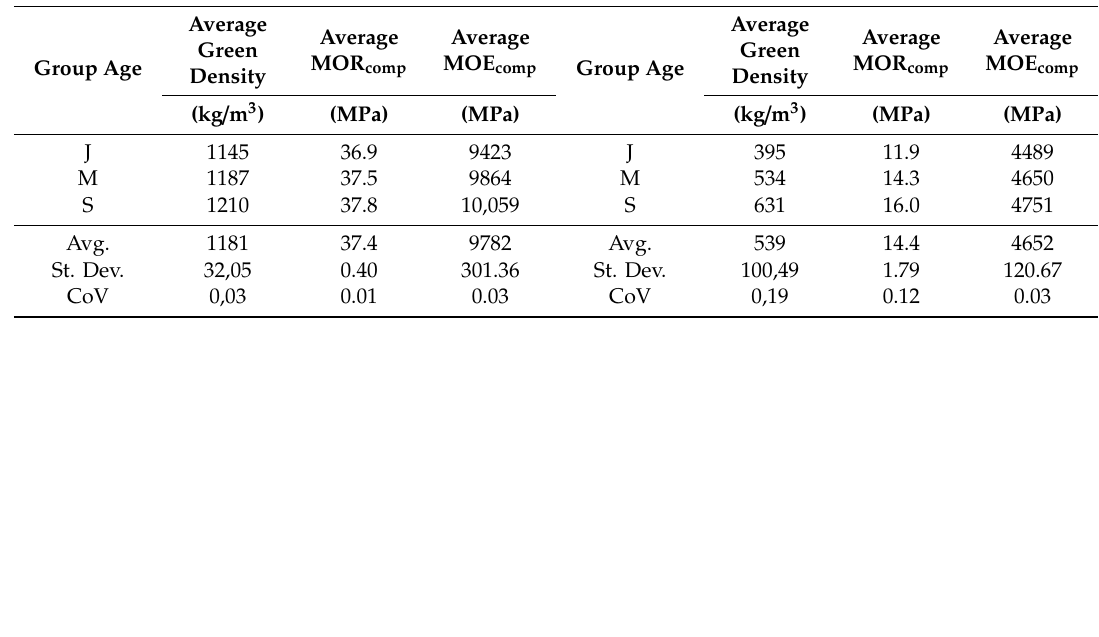
Table 5. Average green modulus of rupture (MOR) and modulus of elasticity (MOE) per wood group age of the Eucalyptus globulus and Cupressus macrocarpa samples tested under the compression mode. Eucalyptus